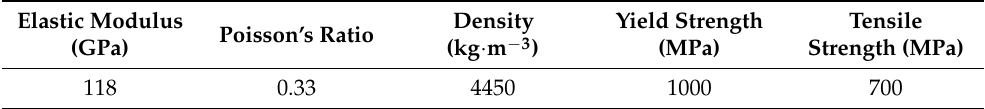
Table 1. TA15 material properties.